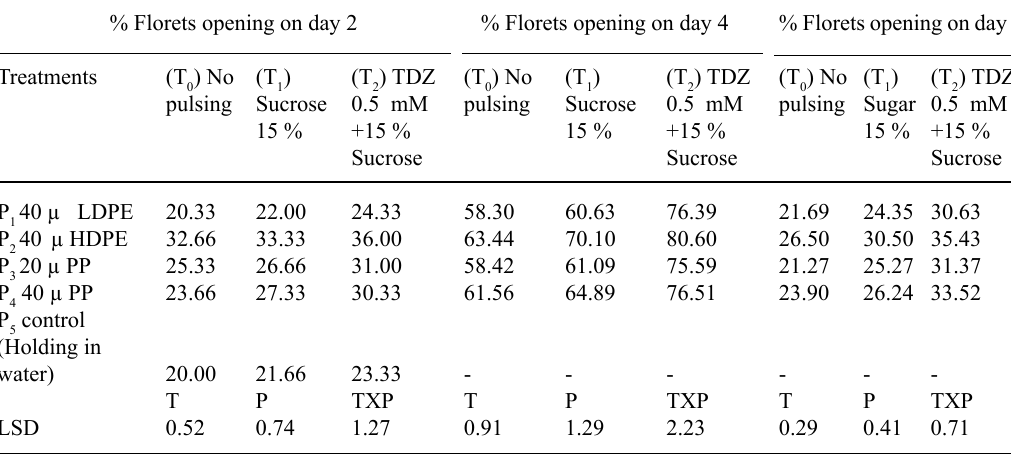
Table 2. Effect of pre-storage pulsing and packaging films on per cent floret opening in tuberose cut spikes cv.